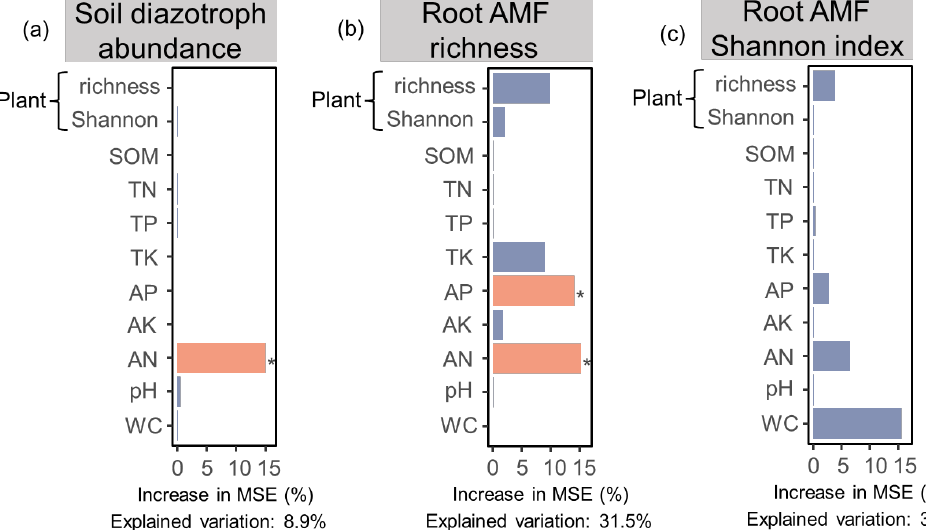
Figure 4. Relative importance of the soil physiochemical property parameters and plant diversities on the soil diazotroph abundance, root AMF richness, and Shannon index using random forests models. ( a ) Diazotroph abundance; ( b ) Root AMF richness; ( c ) Root AMF Shannon index. The asterisk “*” above the yellow indicates a significant effect.